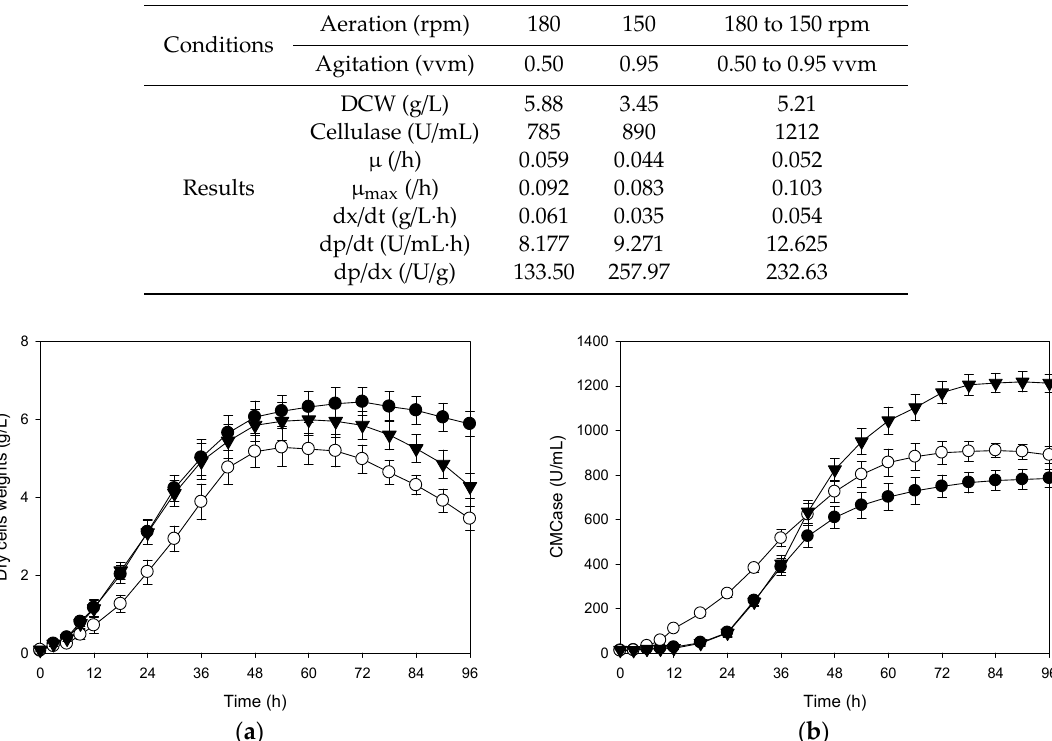
Figure 6. Comparison of ( a ) cell growth and ( b ) production of CMCase by E. coli KACC 91335P under the fixed optimal conditions of aeration rate and agitation speed for cell growth ( ● ), under fixed optimal conditions of aeration rate and agitation speed for production of CMCase ( ○ ) and with shifts in optimal conditions of aeration rate and agitation speed from cell growth to production of CMCase at mid-log phase ( ▼ ).